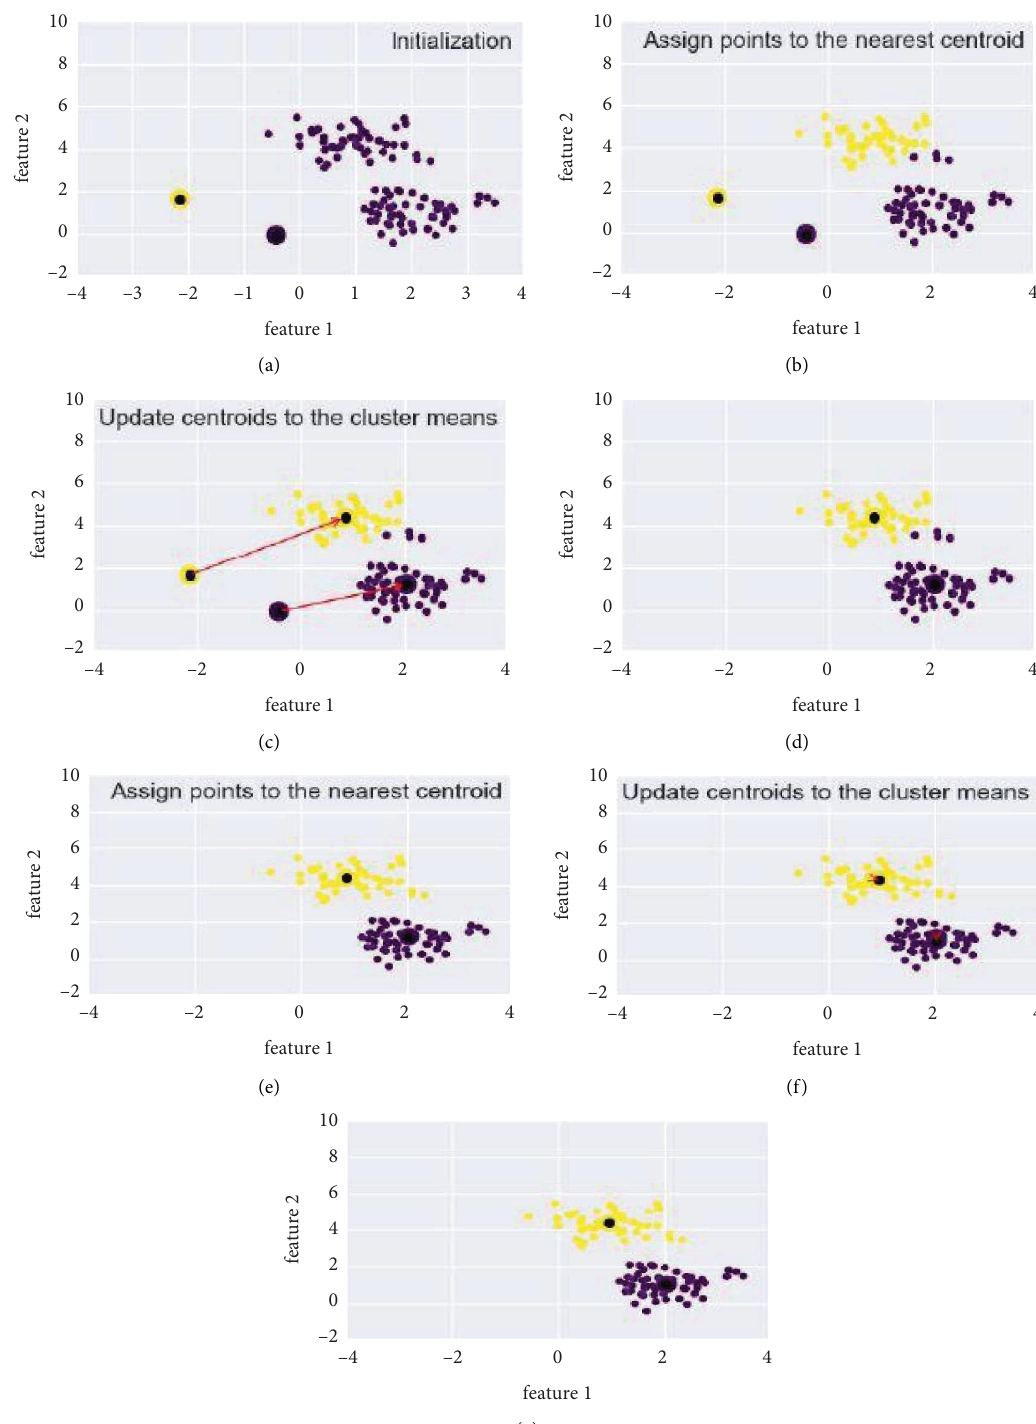
Figure 3: Illustration of K-means